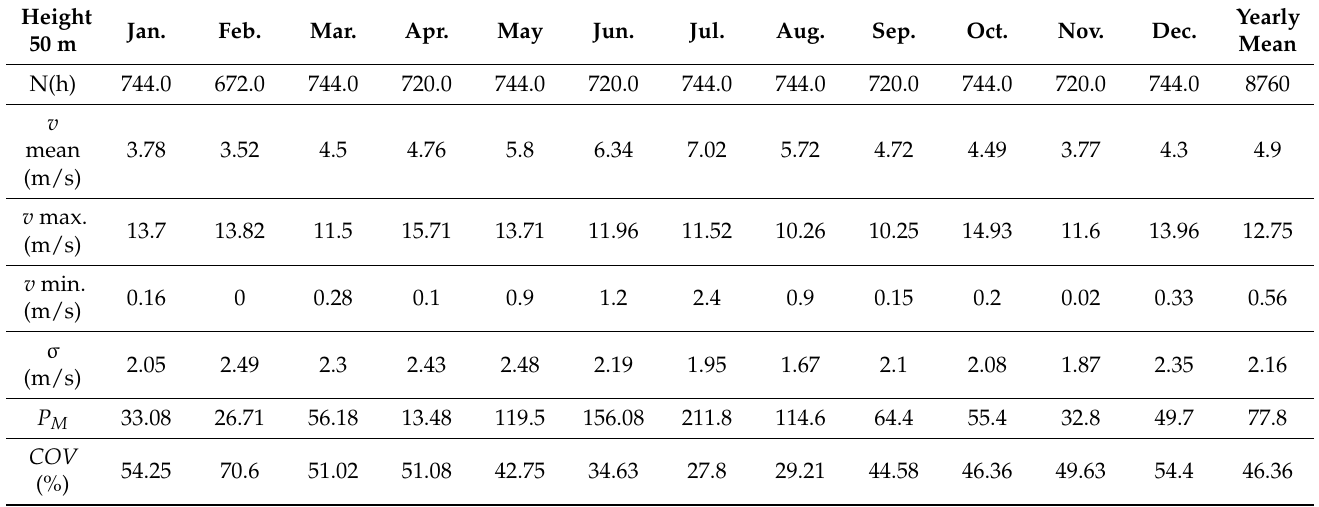
Table 4. The monthly of mean wind speed in (m/s) data for selected wind station at 50 m height. (COV) coefficient of variation during the period 2017.